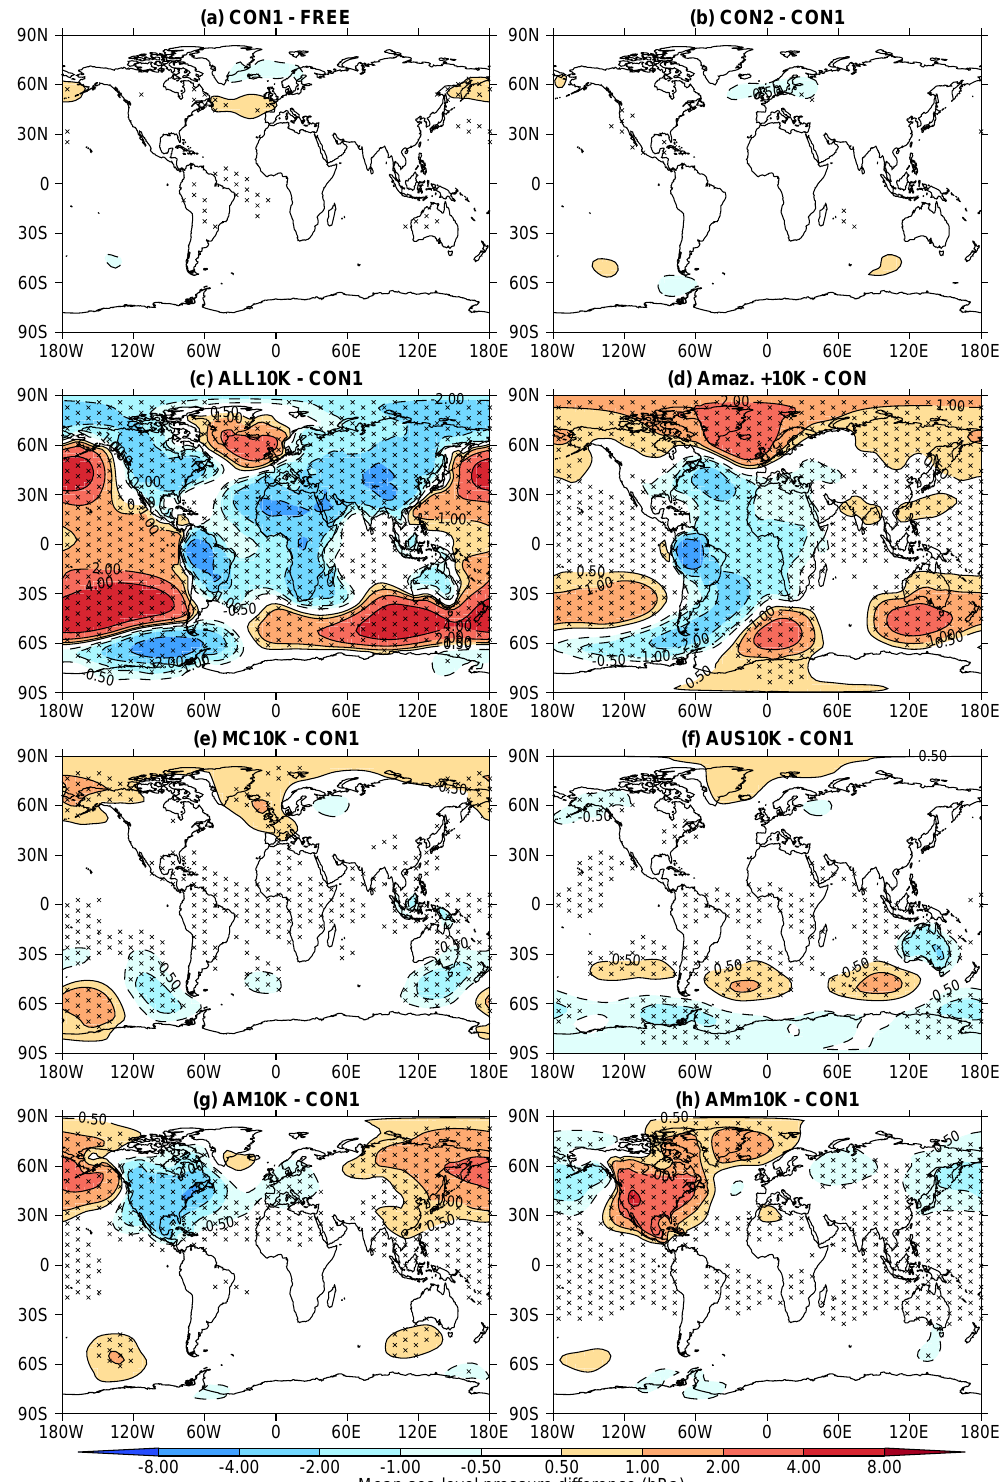
Figure 6. Differences in annual mean, mean sea level pressure (hPa) for (a) CON1 – FREE, (b) CON2 – CON1, (c) ALL10K – CON1, (d) AMA10K – CON1, (e) MC10K – CON1, (f) AUS10K – CON1, (g) AM10K – CON1, and (h) AMm10K – CON1. Values of p ≤ 0.05 are denoted with an